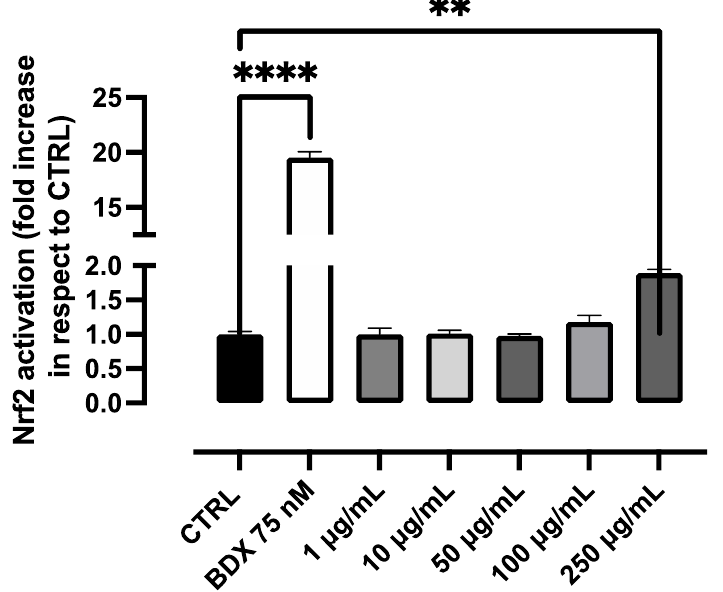
Figure 3. Antioxidant activity of PBJ in the R3/1 cell line with a gene reporter for NRF2. **p < 0.01; ****p < 0.0001.